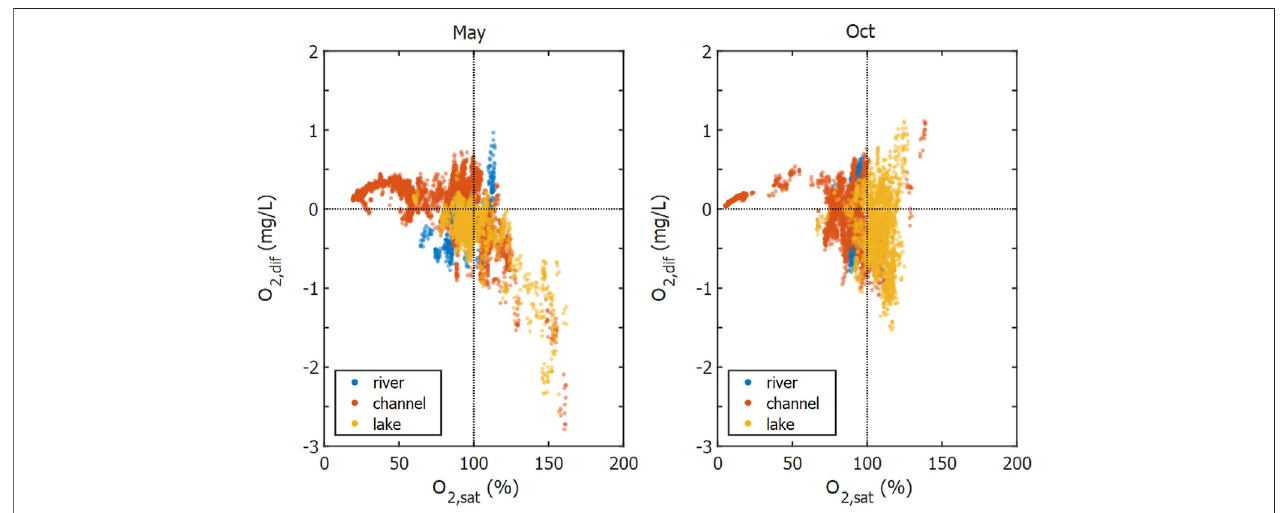
FIGURE10| O 2 concentration differenceofO 2 calculatedfromO 2 :Ar ratio( Eq.4 ).Colorcodingindicates thedifferentwaterscapes. NegativevaluesofO 2 , dif occur for samples with signi fi cant undersaturation in the Ar concentration.